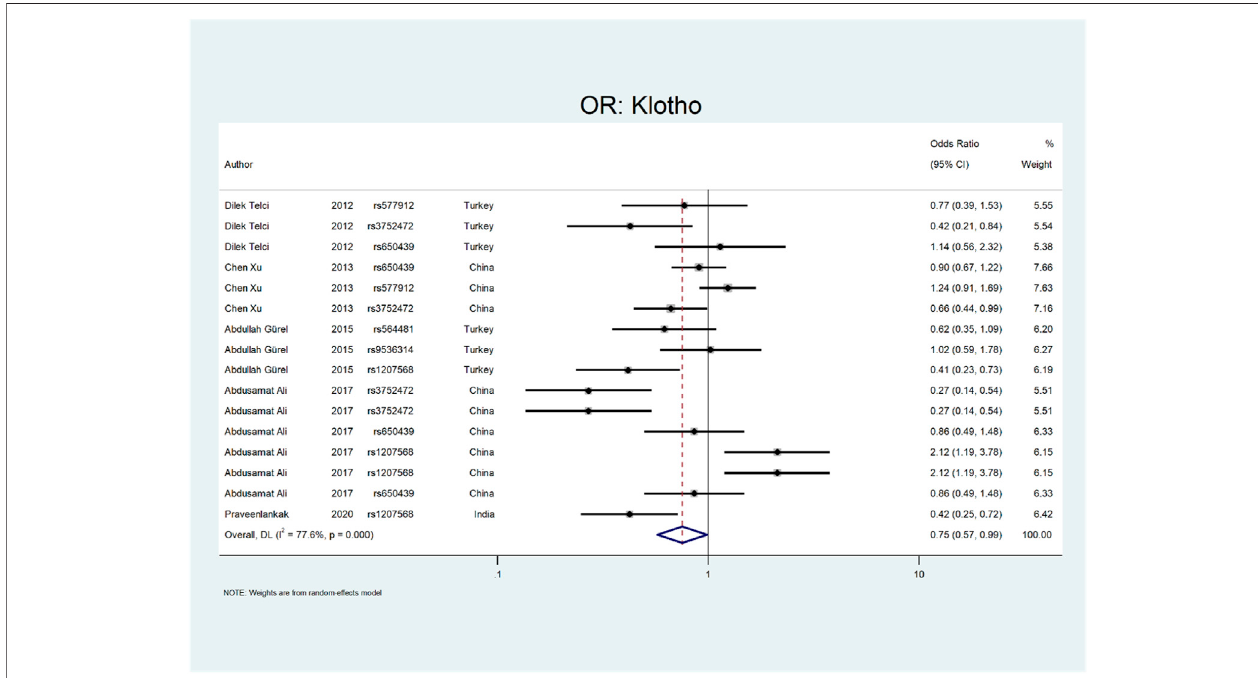
FIGURE 8 | Forest plot: OR for